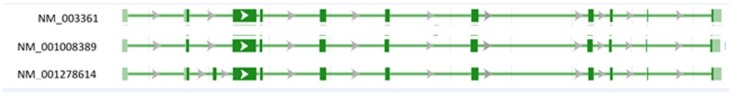
UMOD transcripts.Three UMOD transcripts (3'-5') from NCBI gene website [last accessed: 17/10/2015]. Green blocks indicate the position of exons on the sequence with arrows denoting the direction of expression.